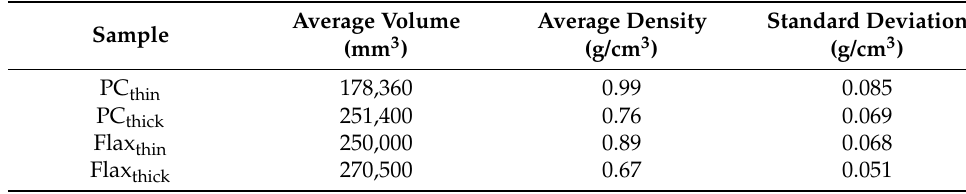
Table 4. Honeycomb-sandwich-panel densities.